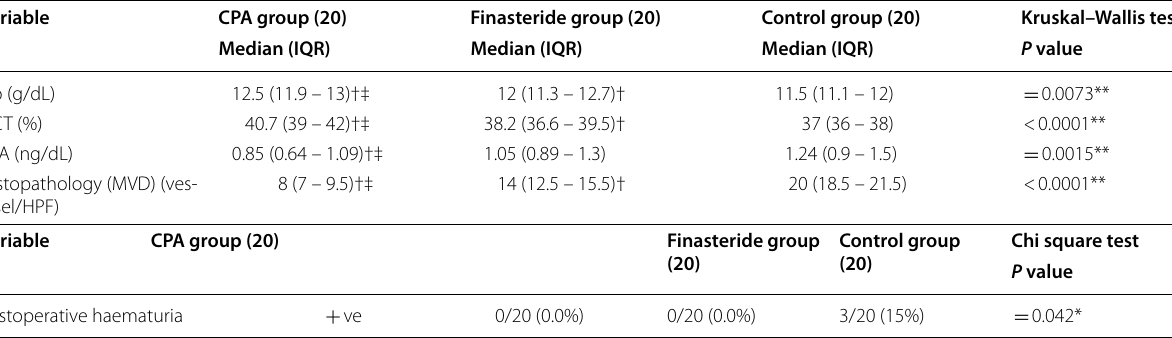
Table 3 Comparison between the 3 groups as regards post‑operative data using Kruskal–Wallis and Chi square tests and significant KW test was followed by post hoc multiple comparisons using Bonferroni test to detect the significant